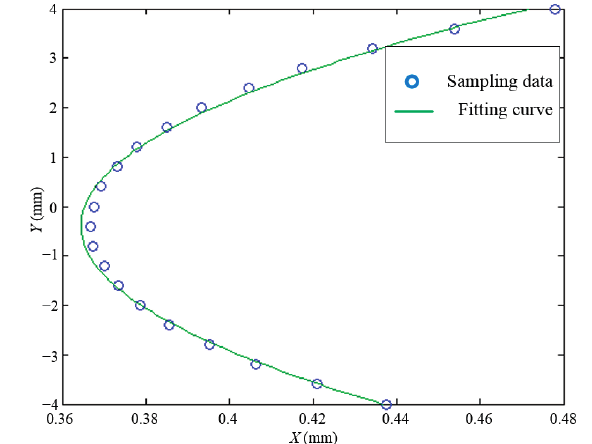
Figure 9. Equipotential line of U = 0.4 V fitted by Equation